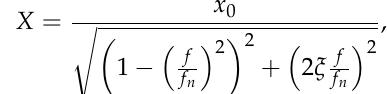
Figure 11. Sensitivity variation of the accelerometer.